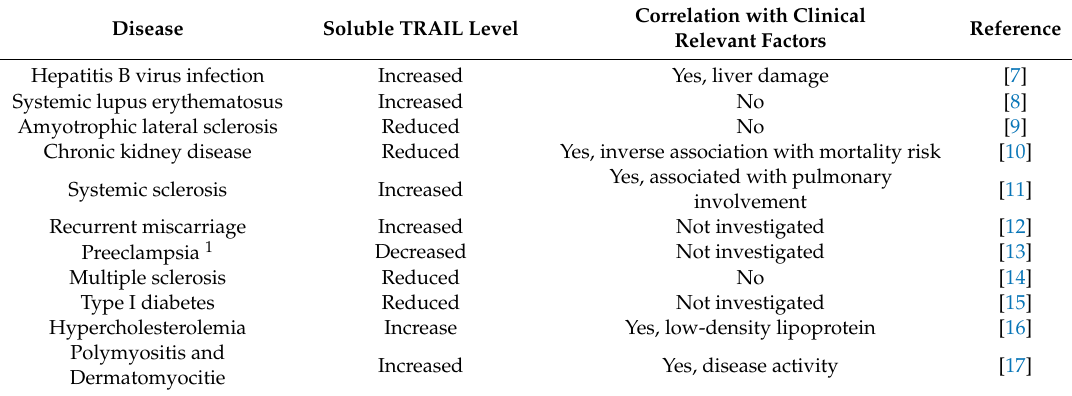
Table 1. Association of serum levels of TRAIL and